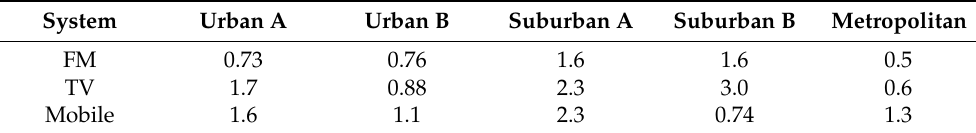
Table 7. Standard deviation of median value [dB].